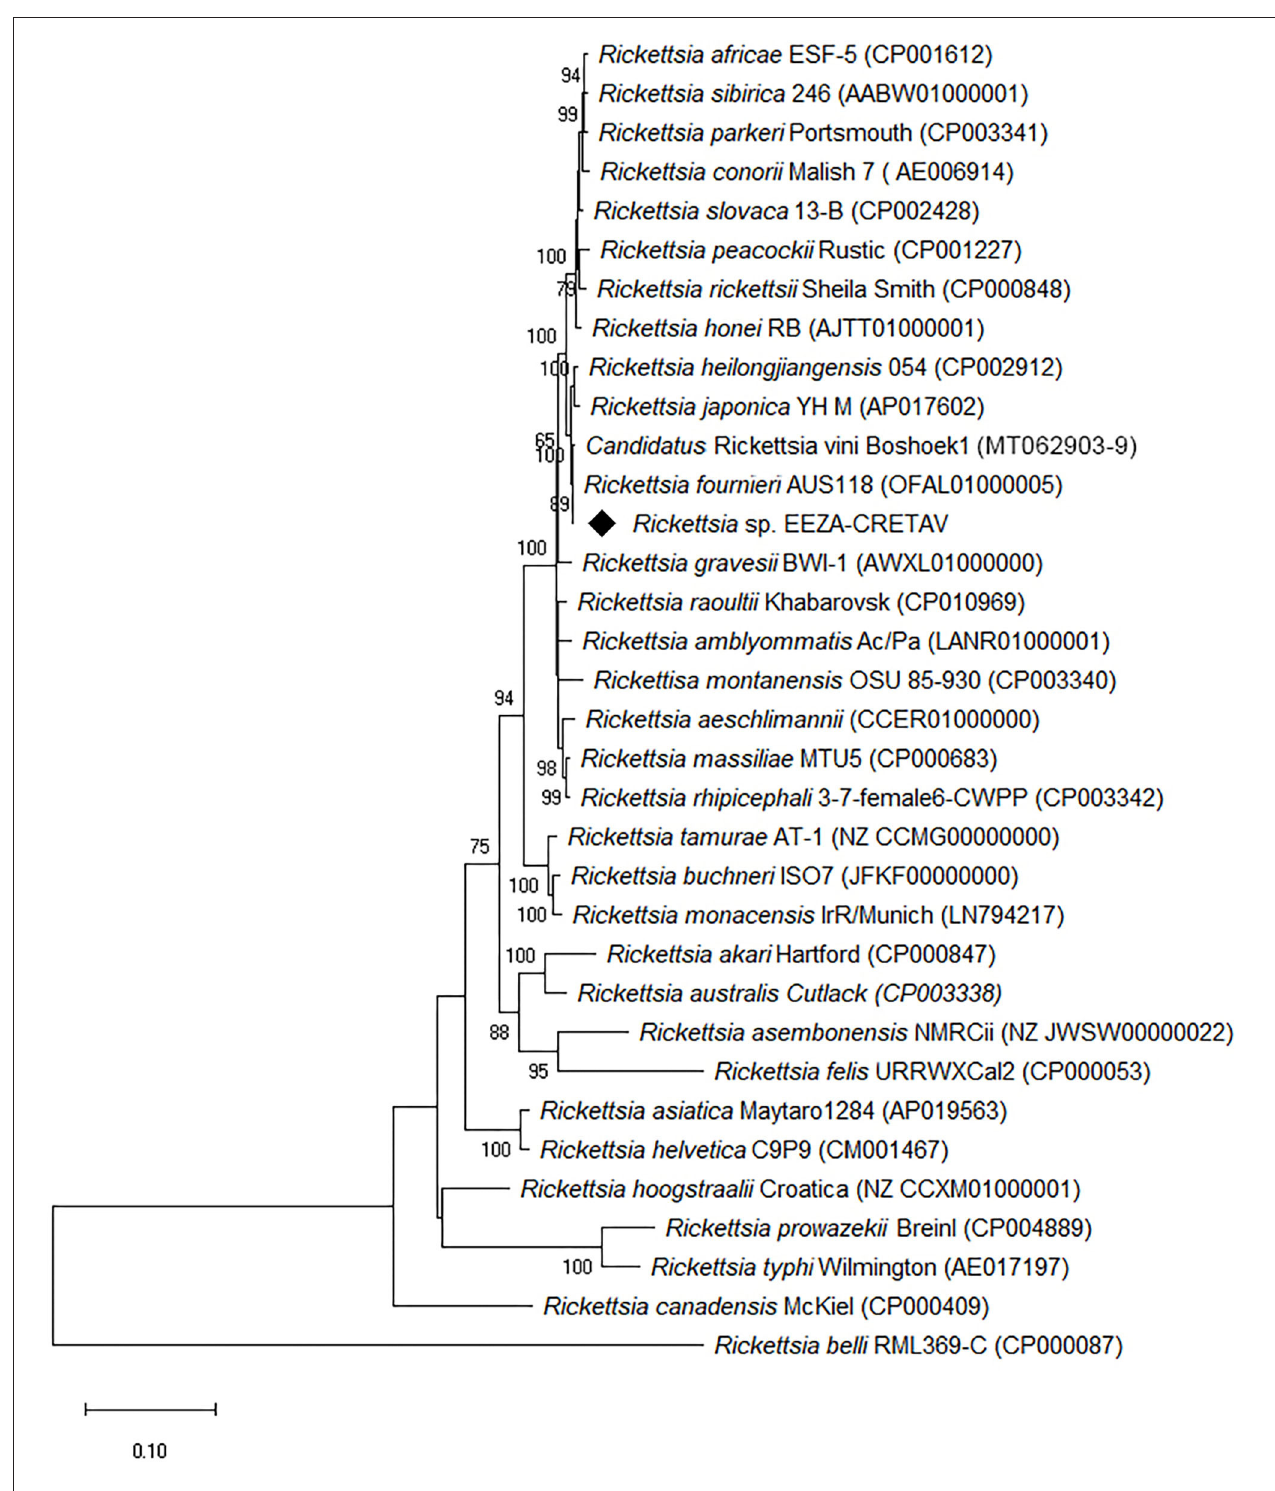
FIGURE 2 | Phylogenetic tree showing the relationships between Rickettsia sp. EEZA-CRETAV and published Rickettsia spp. taxa. The evolutionary analysis was inferred using the maximum likelihood method and general time reversible + G model with Mega X, by concatenating fragments of six genes ( sca4 , 16s rRNA, ompB , ompA , 17-kDa, and gltA ). The analysis involved 34 nucleotide sequences and a total of 4,120 positions in the final dataset. The tree is drawn to scale, with branch lengths measured in the number of substitutions per site. Numbers ( > 65%) shown at the nodes correspond to bootstrapped percentages (for 500 repetitions). The GenBank accession number of the sequences used in the analysis is shown in brackets after Rickettsia taxon name and the corresponding strain. Sequences obtained in this study are marked with diamond.